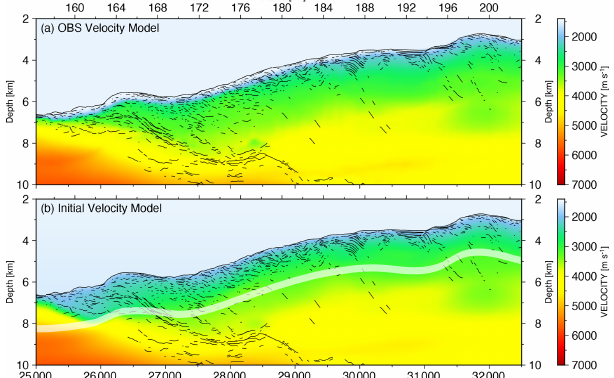
Table 2. Regional depth-variant water velocity extracted from